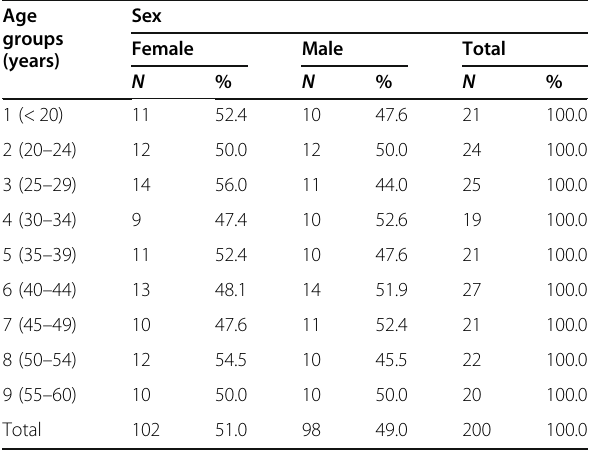
Table 1 Age and sex distribution of the studied subjects ( N = 200) Age